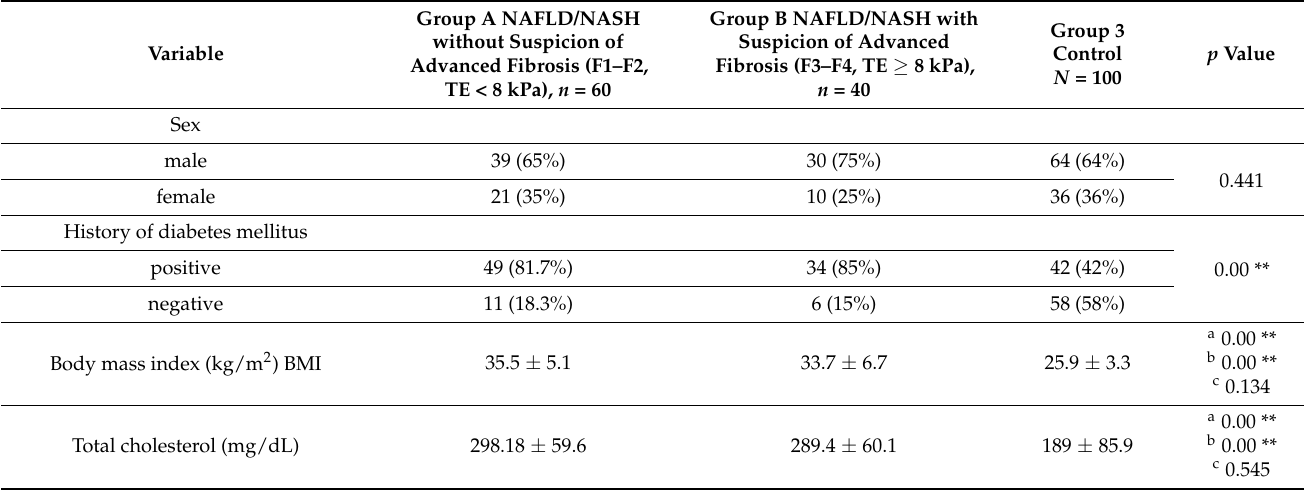
Table 1. Clinical and laboratory characteristics among the groups of the study.